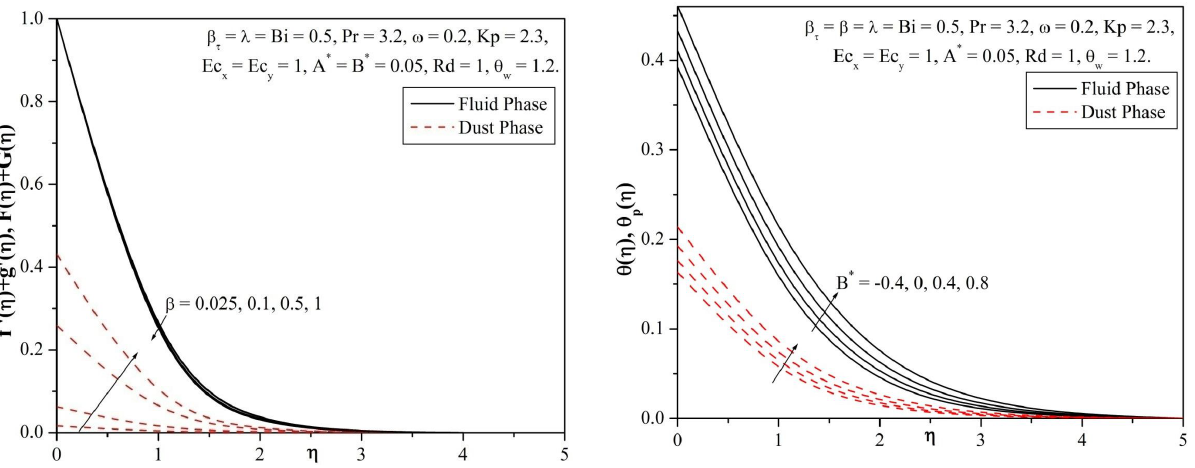
Fig. 9: Dimensionless profiles of ν , ν p velocity components for dif- ferent values of β .